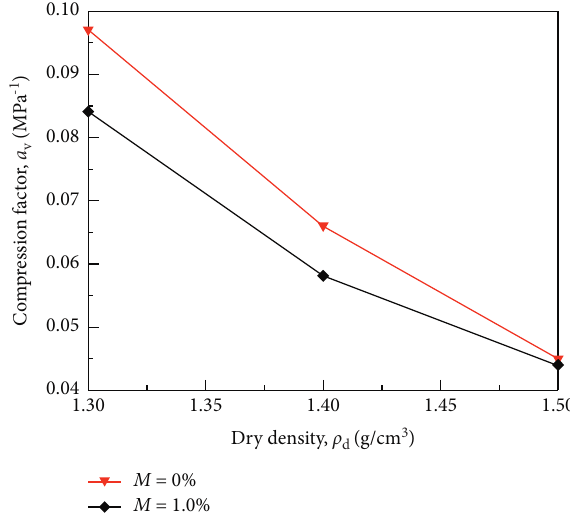
Figure 12: Effect of dry density on compression modulus.